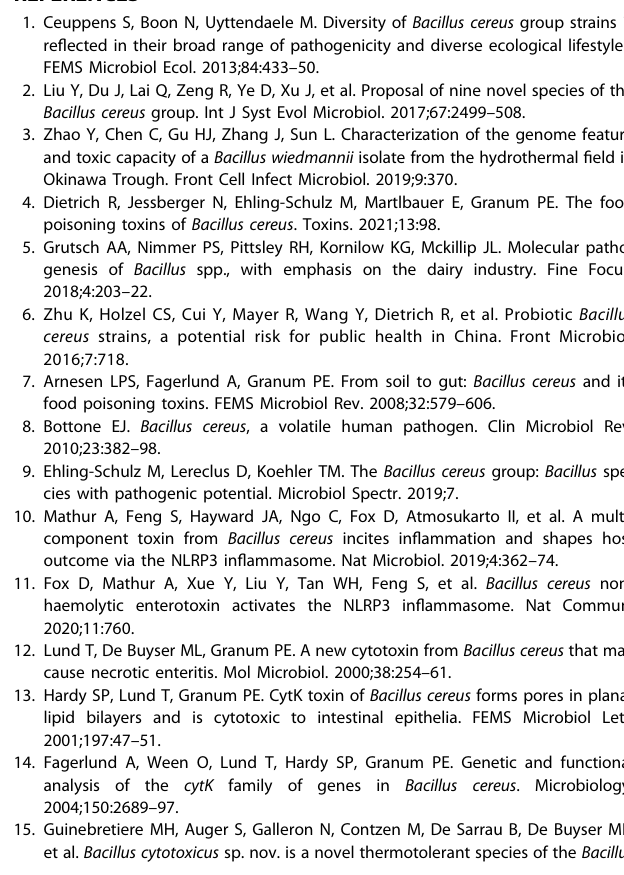
Separation of the cellular membrane and cytosolic fractions The cells of dTHP-1 were incubated with CytK for 25 min, followed by washing in PBS three times. The cells were separated into subcellular fractions by using the Membrane and Cytoplasmic Protein Extraction kit (C510005, Sangon Biotech).